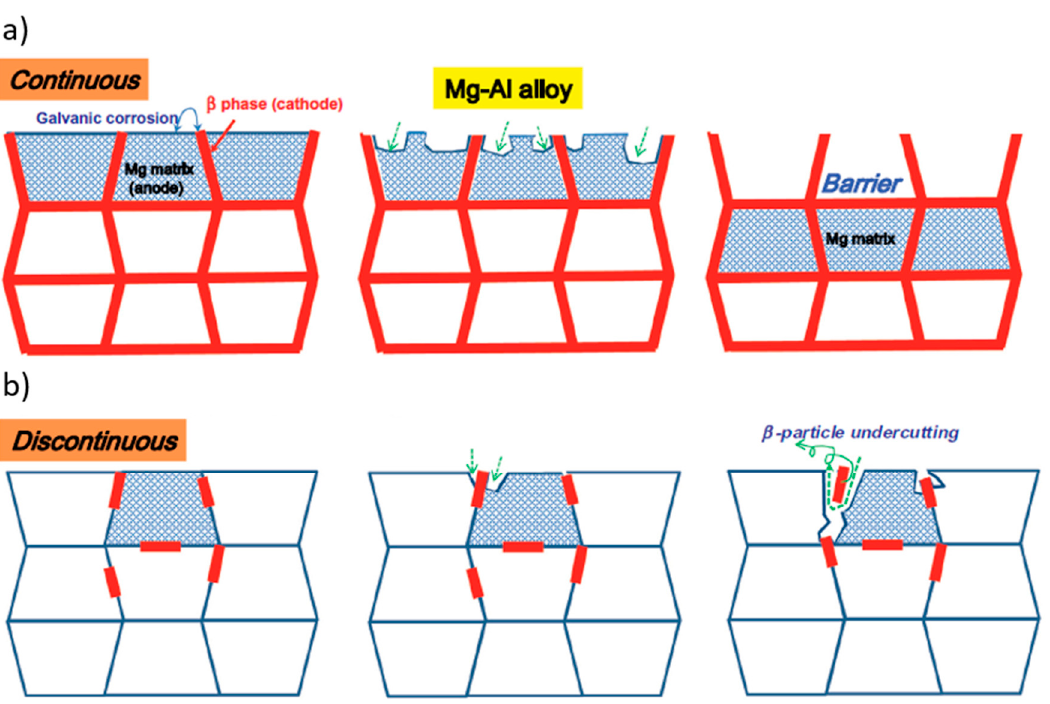
Figure 25. Schematic illustration of the role of Mg 17 Al 12 phases in the Mg matrix whether their distribution is continuous ( a ) or discontinuous ( b ). Reproduced with permission from [139], Elsevier, 2014.